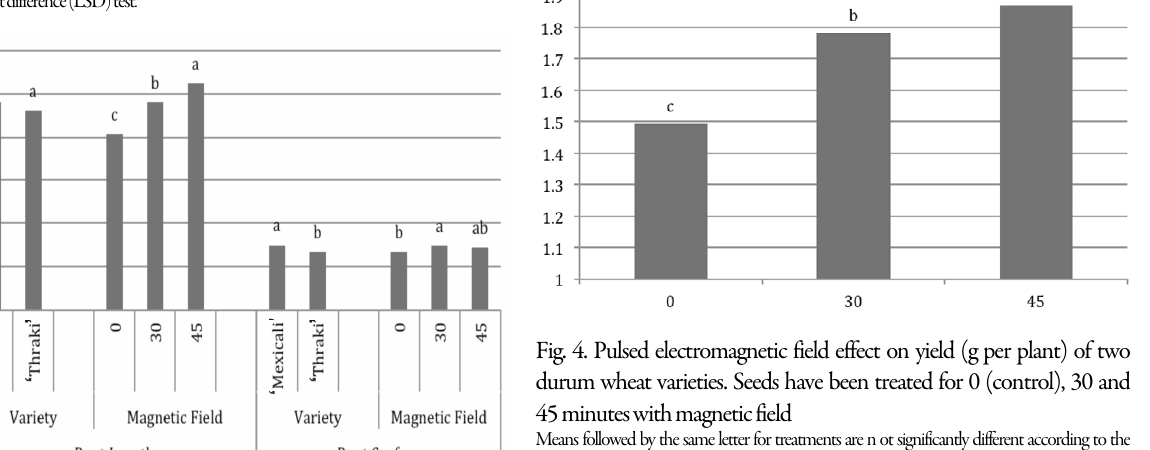
Fig. 1. Interaction of variety and magnetic field treatments on dry weight (g per plant) of two durum wheat varieties. Seeds have been treated for 0 (control), 30 and 45 minutes with magnetic field Means followed by the same letter for treatments are not significantly different according to the least significant difference (LSD) test.